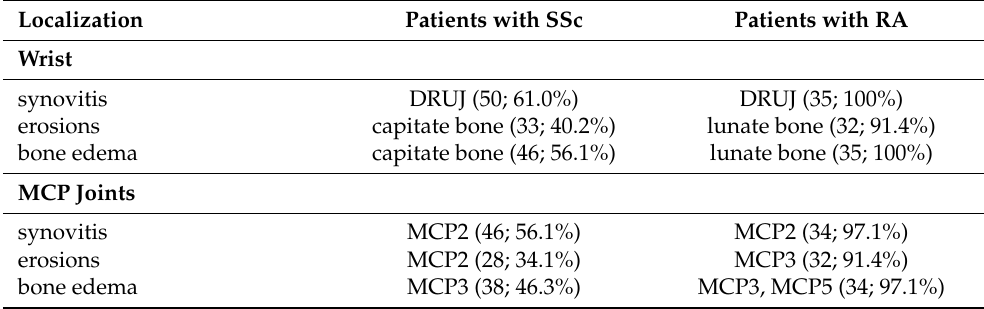
Table 5. Localization of the highest total MRI score in the wrist and MCP joints of dominant hand in patients with SSc and RA. Localization Patients with SSc Patients with RA Wrist synovitis DRUJ (50; 61.0%) DRUJ (35; 100%) erosions capitate bone (33; 40.2%) lunate bone (32; 91.4%) bone edema capitate bone (46; 56.1%) lunate bone (35; 100%) MCP Joints synovitis MCP2 (46; 56.1%) MCP2 (34; 97.1%) erosions MCP2 (28; 34.1%) MCP3 (32; 91.4%) bone edema MCP3 (38; 46.3%) MCP3, MCP5 (34; 97.1%)